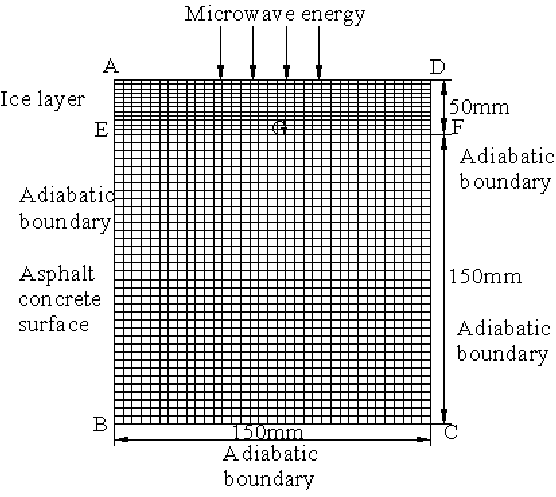
Figure 2. Grid division diagram of the microwave deicing.